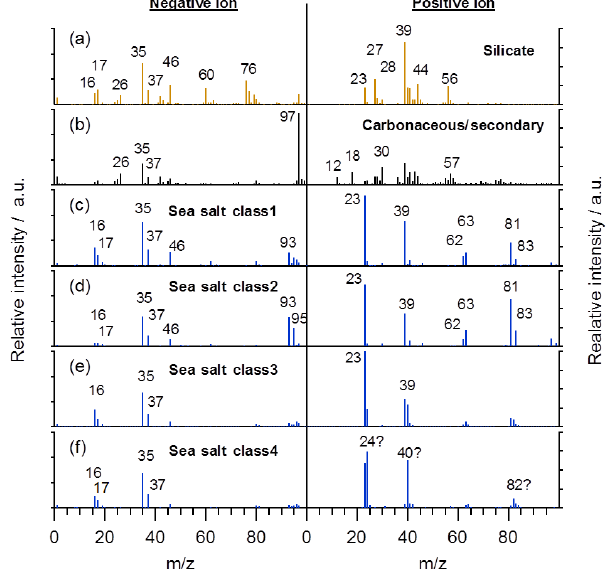
Figure 10. Representative spectral patterns of the cluster centres (a– f) produced by fuzzy c-means cluster analysis of ambient data ac- quired at Praia, Cabo Verde, during the ICE-D campaign in Au- gust